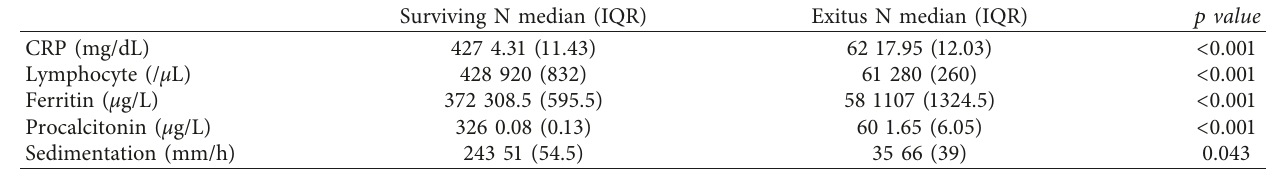
Table 2: Comparison of laboratory data according to the outcome.